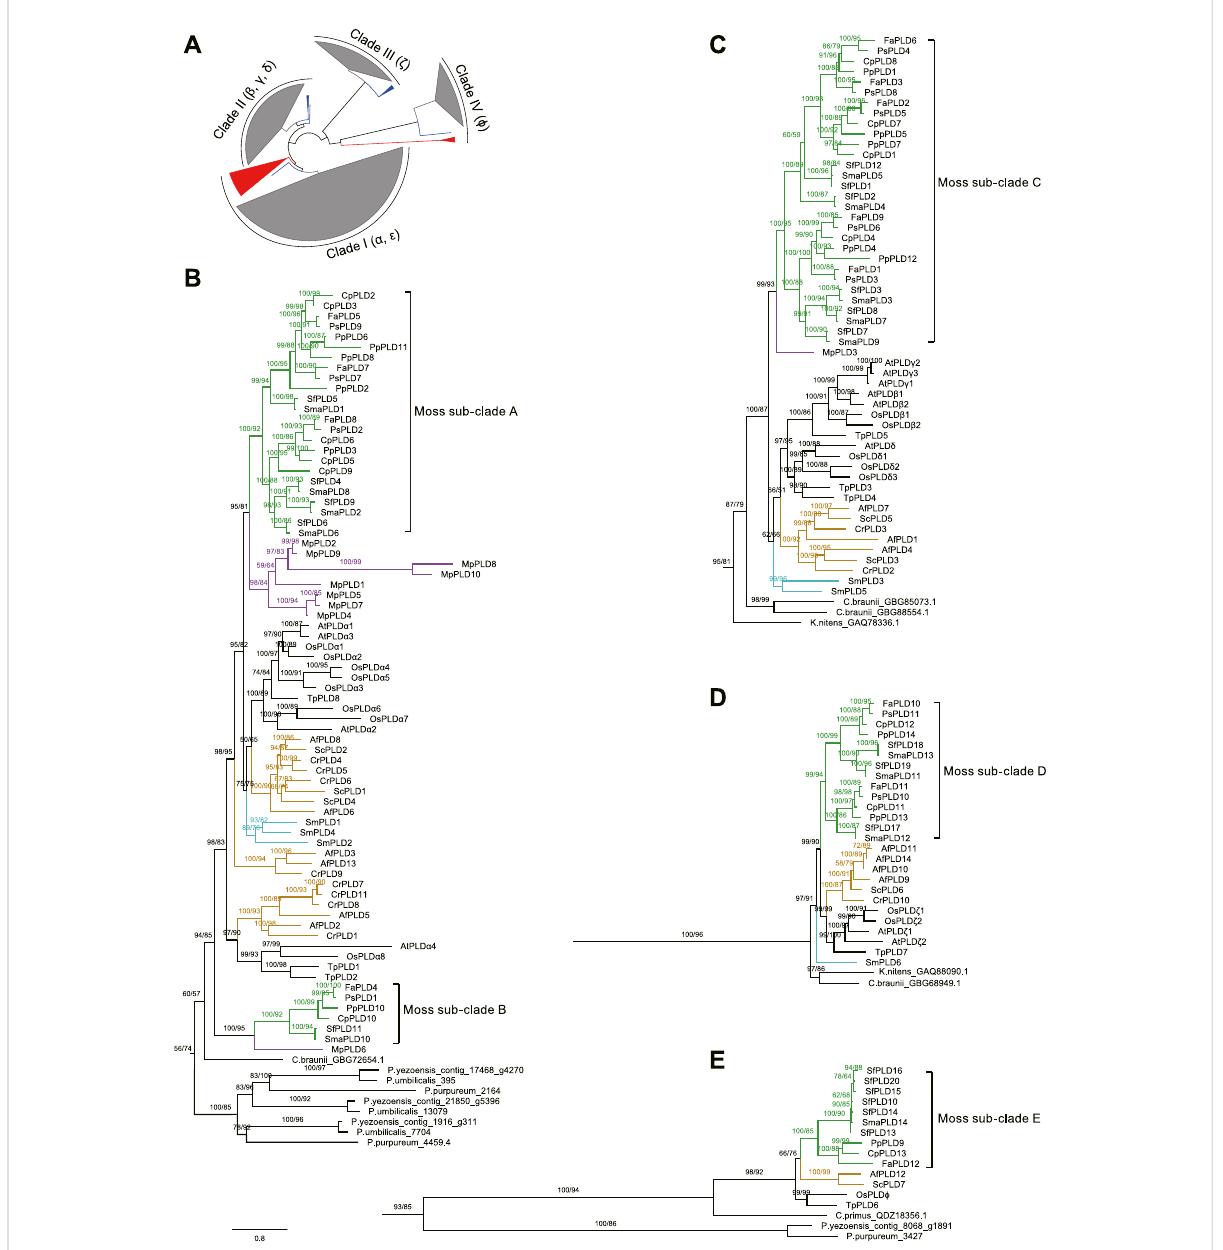
FIGURE 3 Phylogenetic unrootedtreeofPLDsfrommosses,clubmosses,liverworts,ferns,angiosperms,andalgae.BecauseitwasnotclearwhentheC2, PX/PH, and SP PLD subfamilies diverged (perhaps long before the emergence of red algae), no outgroup was used for this tree. (A) : A simpli fi ed overview of the entire phylogenetic tree with clades I, II, III, and IV collapsed. Blocks colored in grey, red, and blue represent PLDs of land plants (mosses, clubmosses, liverworts, ferns, and angiosperms) and red and green algae, respectively. (B – E) :Phylogenetictopologies within clades I, II, III, and IV, respectively. The original phylogenetic tree is displayed in Supplementary Figure S2. The sequence alignment used was provided in supplementary data sheet 1. Above branches are bootstrap supports from maximum likelihood and Bayesian analyses, respectively. The bootstrap value below 50% is not shown. The green, purple, orange, and cyan color on the branches refer to mosses, liverworts, ferns, and clubmosses, respectively. Scale bar represents substitution numbers per amino-acid site for (B – E) . The abbreviations used are as follows: Pp, P. patens ; Cp, C. purpureus ; Fa, F. antipyretica ; Ps, P. schreberi ; Sma, S. magellanicum ; Sf, S. fallax ; Sm, S. moellendorf fi i ; Cr, C. richardii ; Af, A. fi liculoides ; Sc, S. cucullate ; Mp, M. polymorpha ; At, A. thaliana ; Os, O. sativa ; Tp, T. plicata